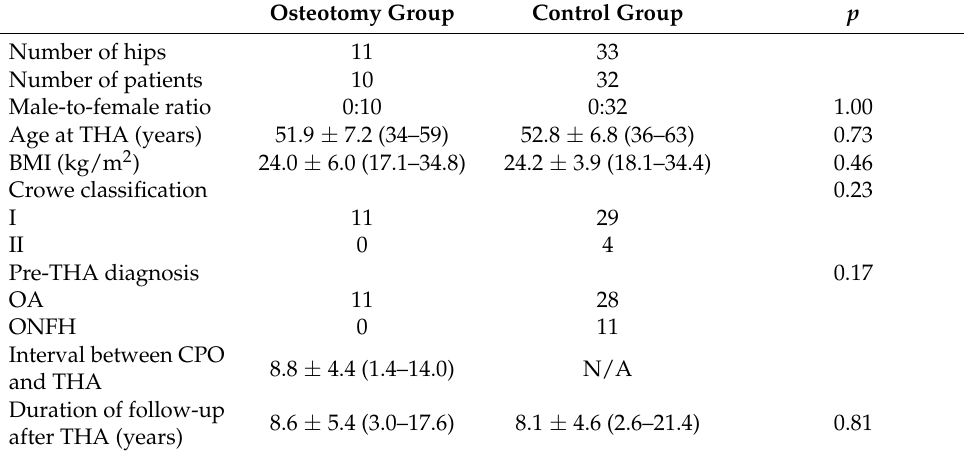
Table 2. Patient demographic characteristics.